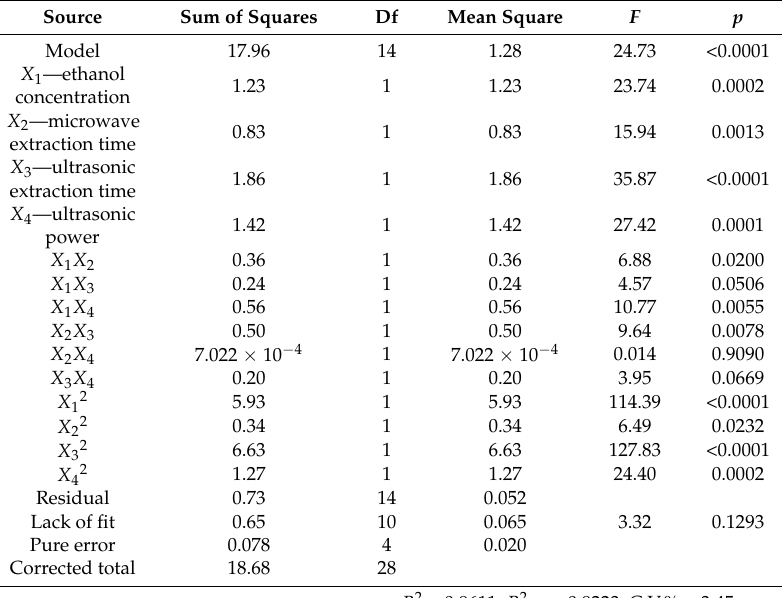
Table 2. Test of significance for regression